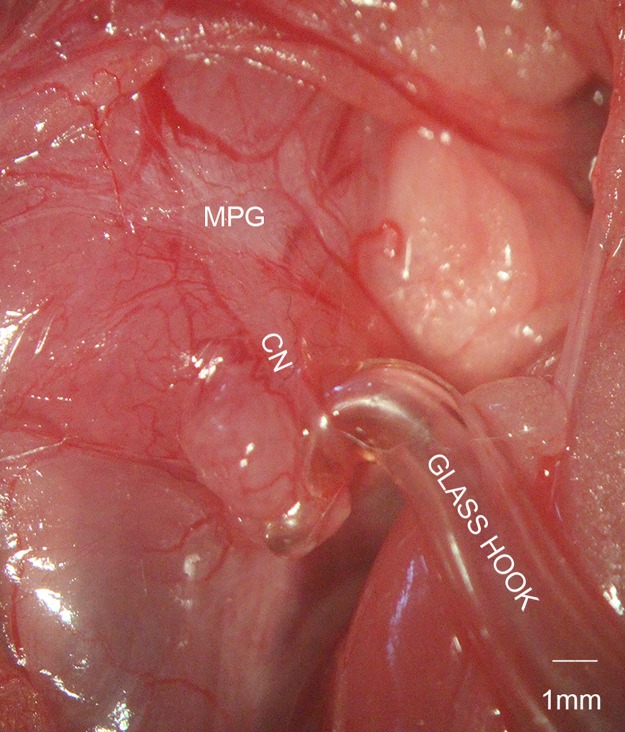
Cavernous nerve (CN) traction model.The CN is separated from the surface of prostate between the major pelvic ganglion (MPG) and apex of the prostate, and then pulled by a glass hook with a force of 0.2 Newton.